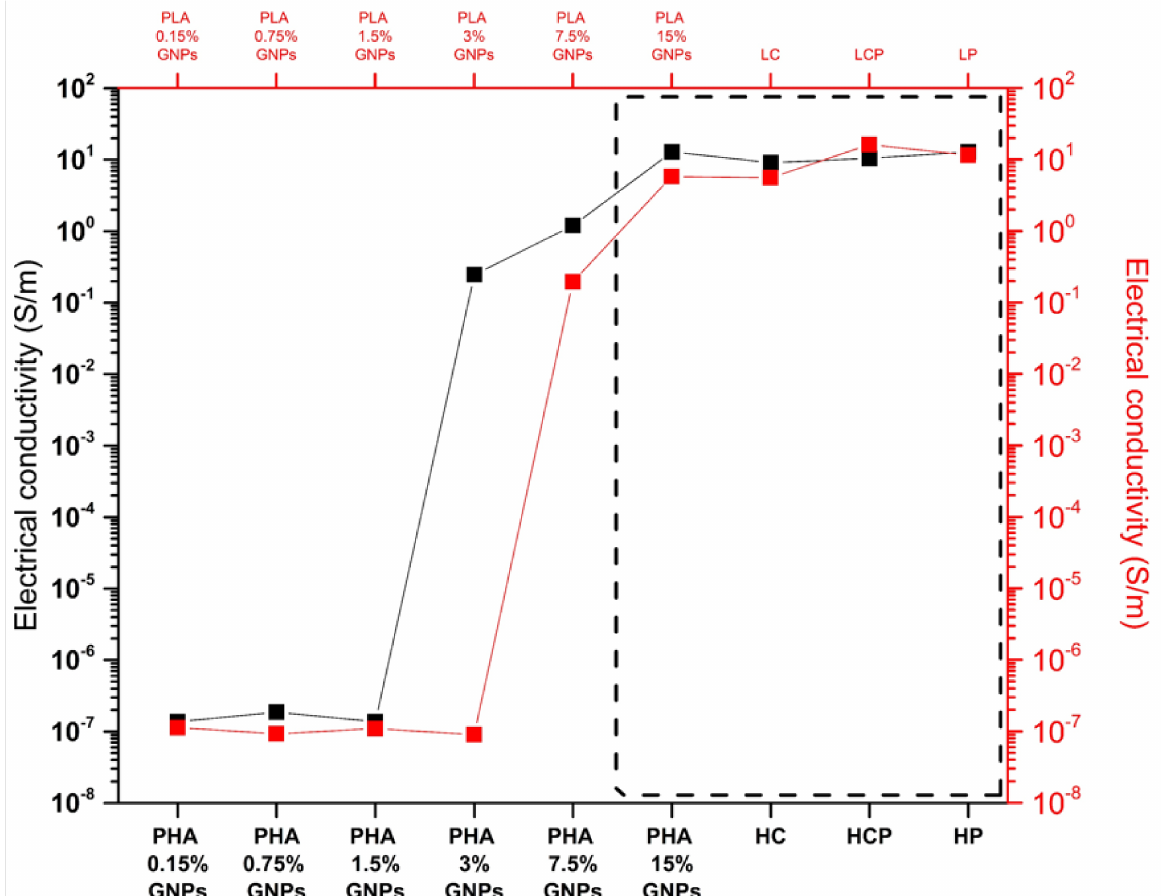
Figure 7. Electrical conductivity values of the films with different GNPs concentrations—PHA (black) and PLA (red) and with the highest GNPs concentration (15 wt.%) and the different additions, CNC and PEG (in the black dashed square on the